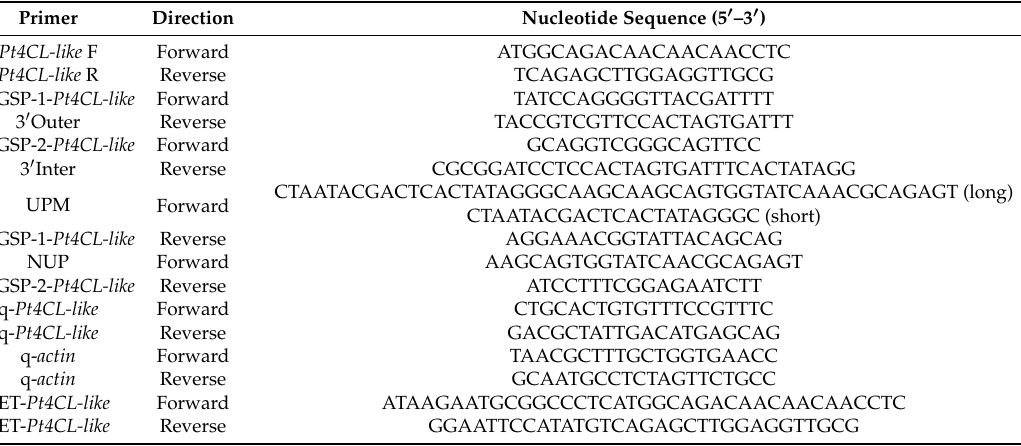
Table 1. Gene-specific